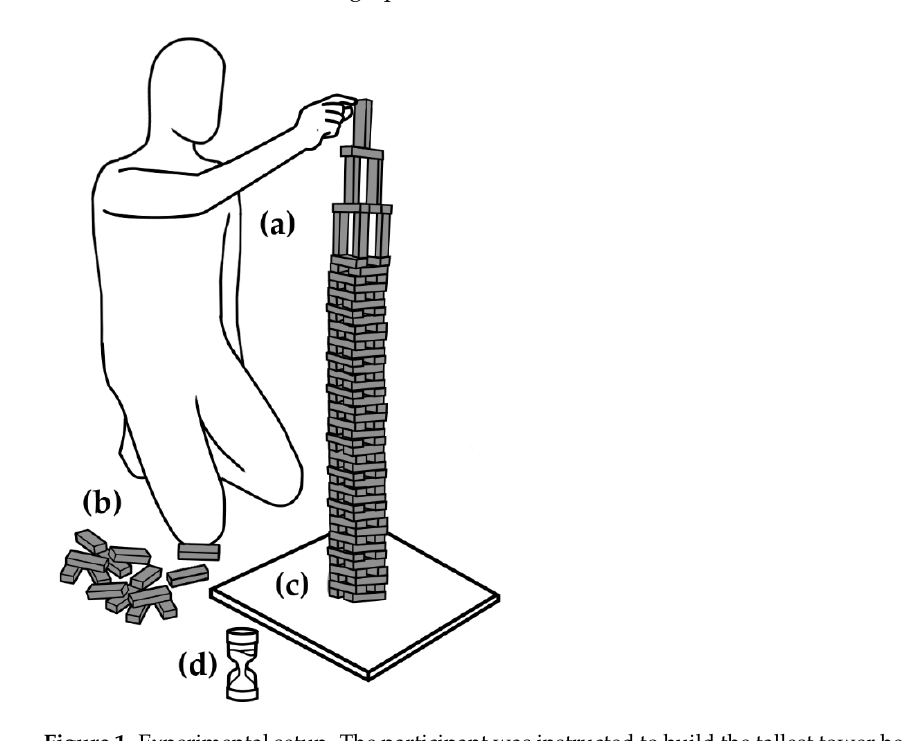
Figure 1. Experimental setup. The participant was instructed to build the tallest tower he or she could ( a ) using standard size wooden blocks ( b ) over a flat, uniform melamine surface ( c ) before time on the hourglass ran out ( d ). See text for additional instructions that varied per experimental condition.